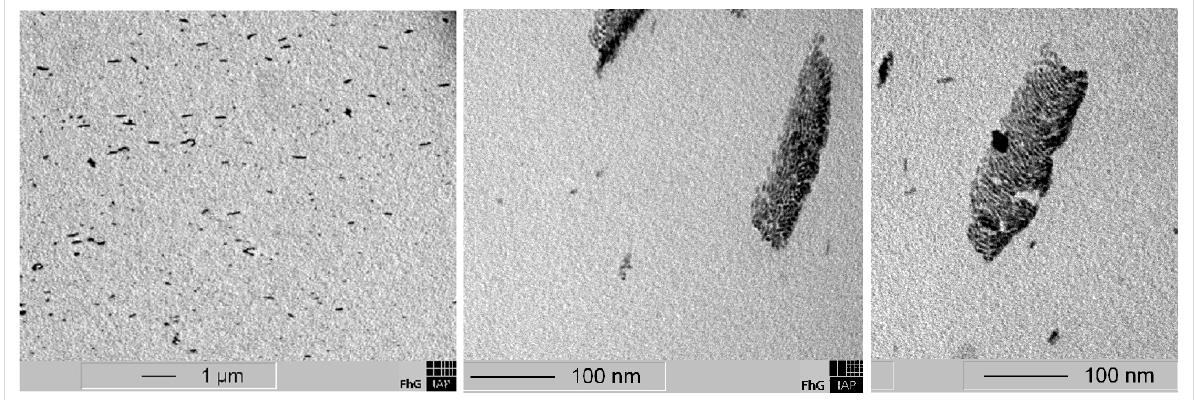
Figure 12: a) TEM images of a CTA nanocomposite layer with 2 wt % NRs (aspect ratio 6) and b) agglomerates with parallel and c) perpendicular NR orientation.